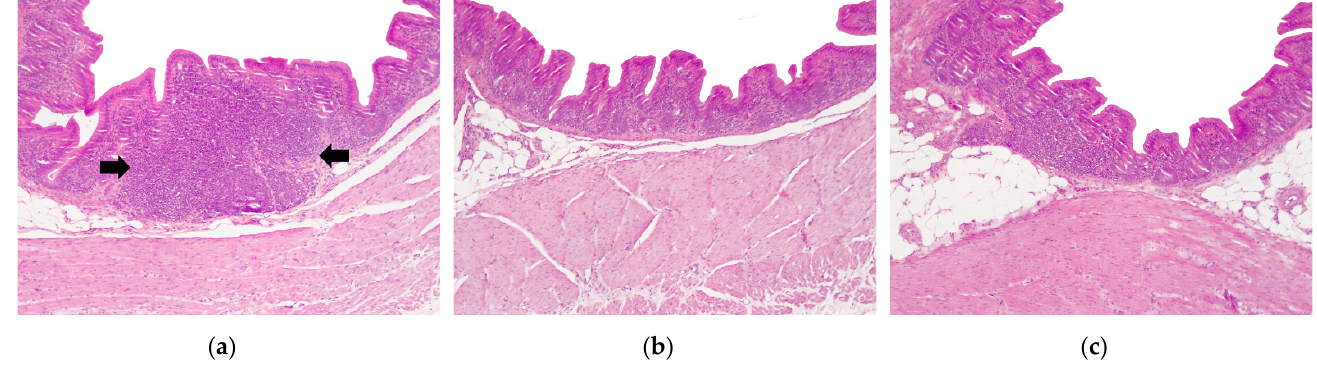
Figure 2. Histopathological study of the cecum of 80 and 108-week-old laying hens infected with Brachyspira and supplemented with fermented defatted ‘alperujo’. ( a ) Non-supplemented groups. Moderate chronic diffuse lymphoplasmacytic and heterophilic typhlitis and marked GALT hyper- plasia (arrows). ( b ) Two percent supplemented groups. There is a marked reduction in the lesion severity compared with non-supplemented hens. ( c ) Six percent supplemented groups. There is a reduction in the inflammation compared with non-supplemented hens. Hematoxylin-eosin, 100 × , scale bar: 200 µ